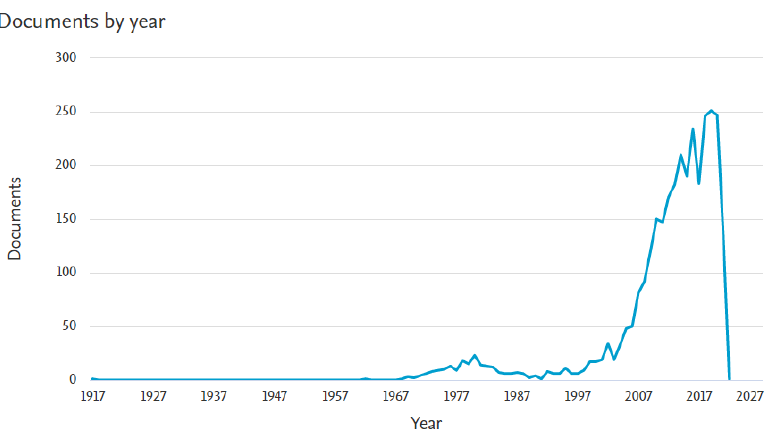
Figure 1. Number of papers on regenerative braking on the Scopus database (data after 2020 incom- plete).